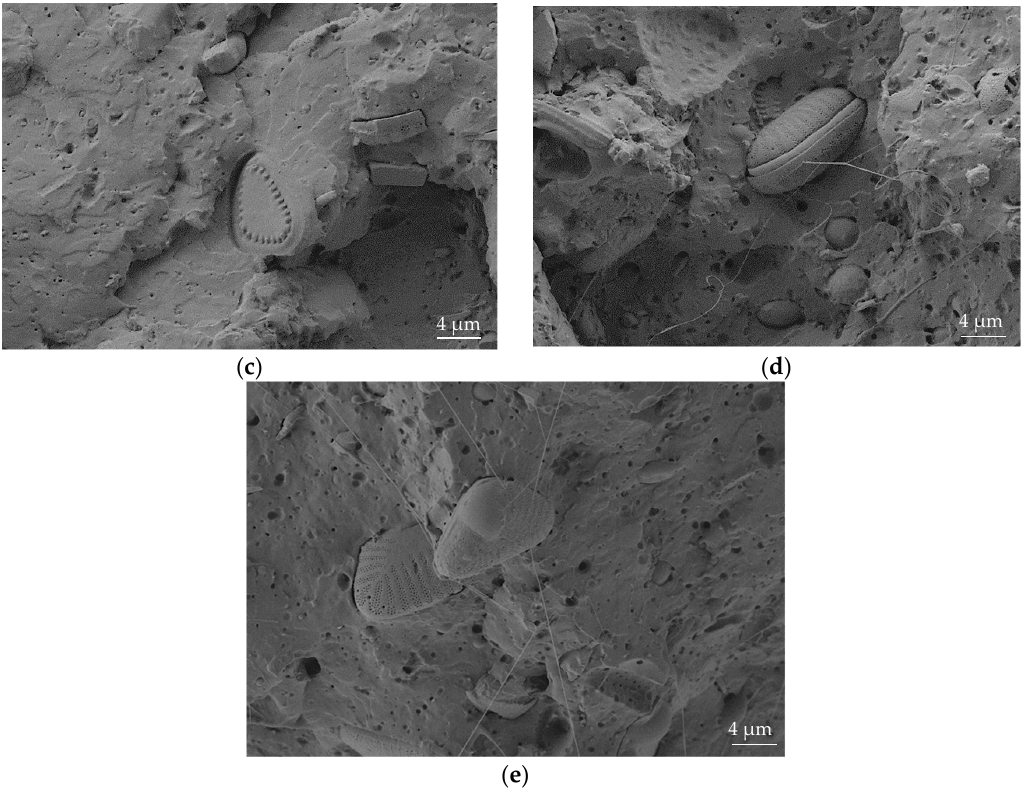
Figure 6. FESEM images (2500×) of the surface of a PLA/DE sample obtained after impact test, with Figure 7. FESEM images (2500 × ) of the surface of a PLA / DE sample obtained after impact test, varying MLO loading (in phr): ( a ) 1, ( b ) 2.5, ( c ) 5, ( d ) 10 and ( e ) 15. with varying MLO loading (in phr): ( a ) 1, ( b ) 2.5, ( c ) 5, ( d ) 10 and ( e )